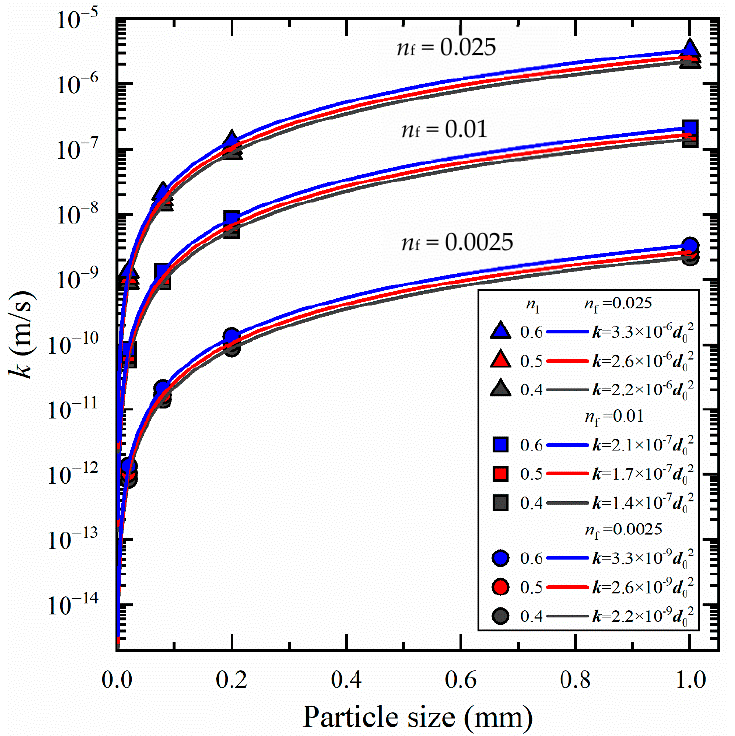
Figure 5. The hydraulic conductivity vs. the mobile porosity.